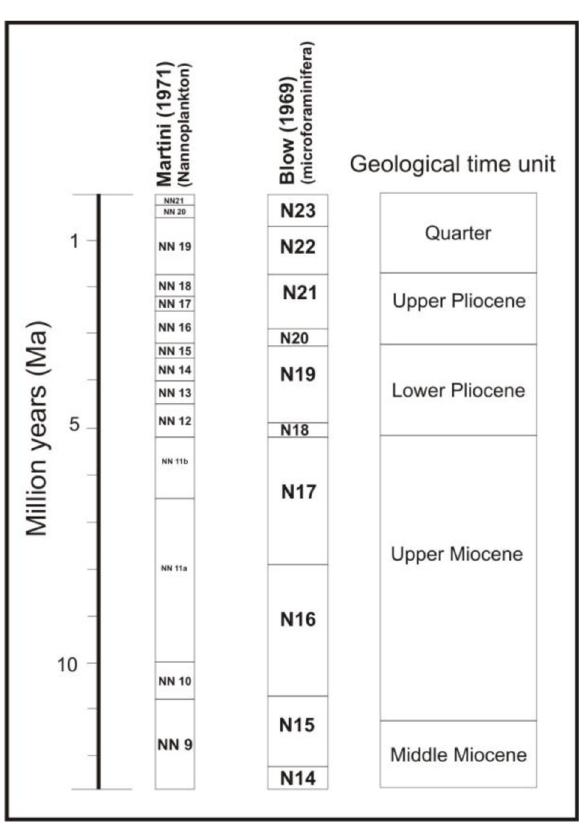
Figure 6. Correlation between two time units based on nanno- planktonic and microplanktonic foraminiferas